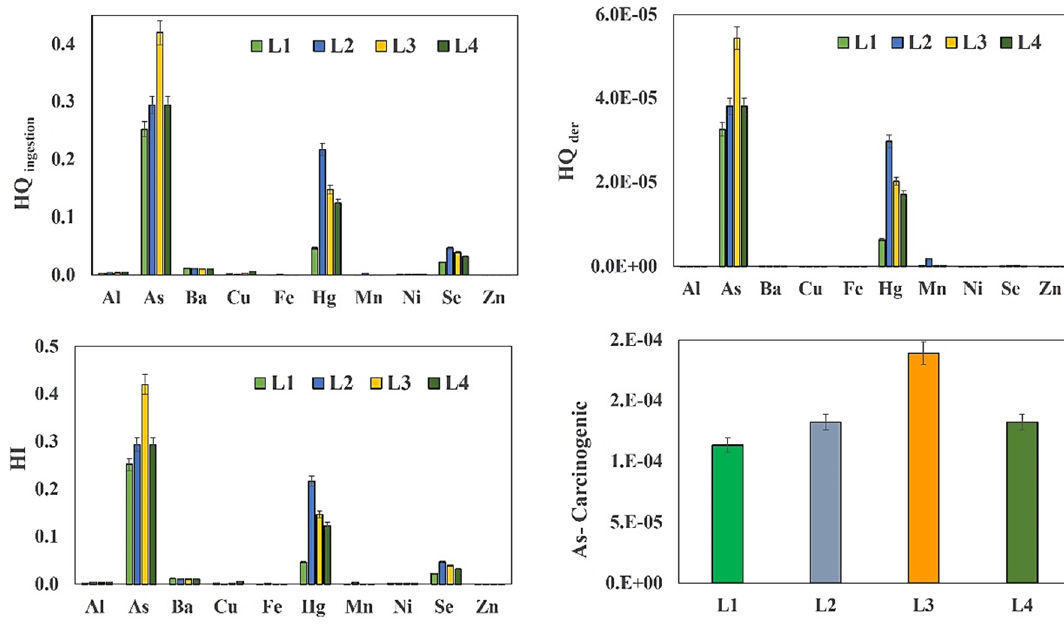
Fig. 4 HQ ingestion , HQ der , HI, and As cancer risk for each heavy metal of Diyala-Sirwan river at all sampling